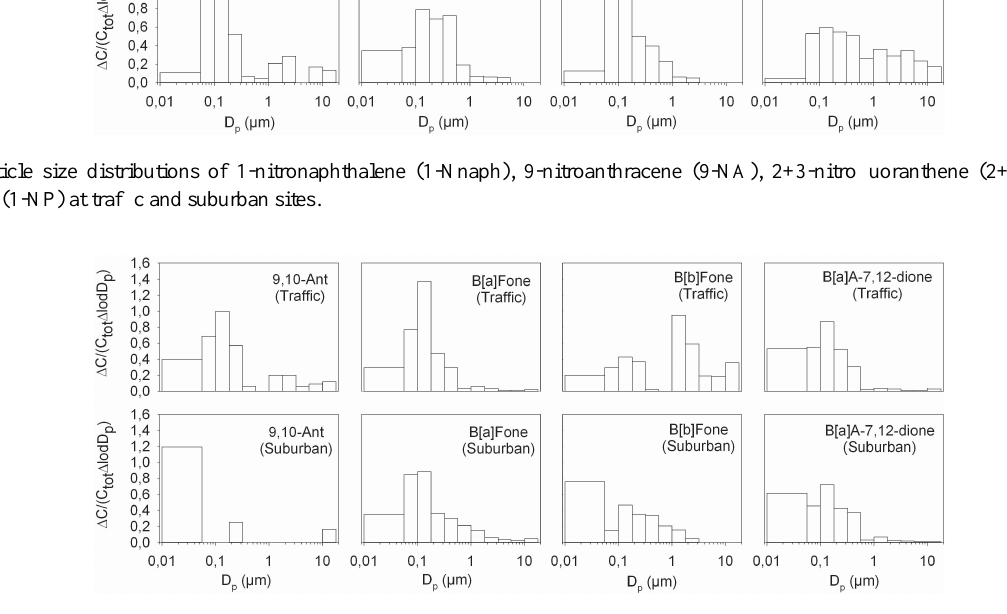
Fig. 5. Particle size distributions of 9,10-anthraquinone (9,10-Ant), benzo[a]fluorenone (B[a]Fone), benzo[b]fluorenone (B[b]Fone)